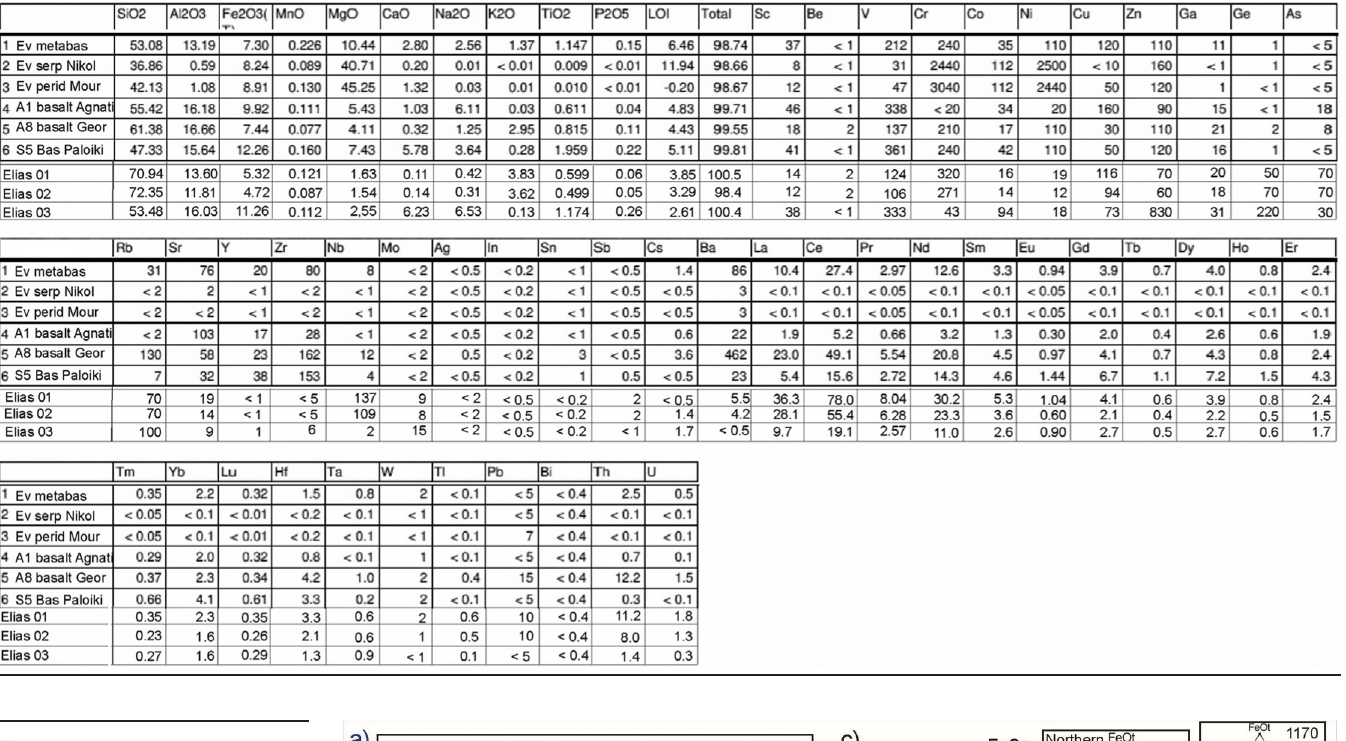
Chondrite-normalised REE and ternary discrimination diagrams. a) LREE enriched samples, probably IABs. b) Flat REE and LREE depleted samples, most likely MORBs (see text). c) Discrimination diagrams: Vardar zone data (AFMs are also shown for Evvoia and the Northern Sporades). The AFM from Perfit and others [70] shows the plots of 1170 IABs (the dashed red line area in the Vardar diagram, encompassing only a few of the Vardar